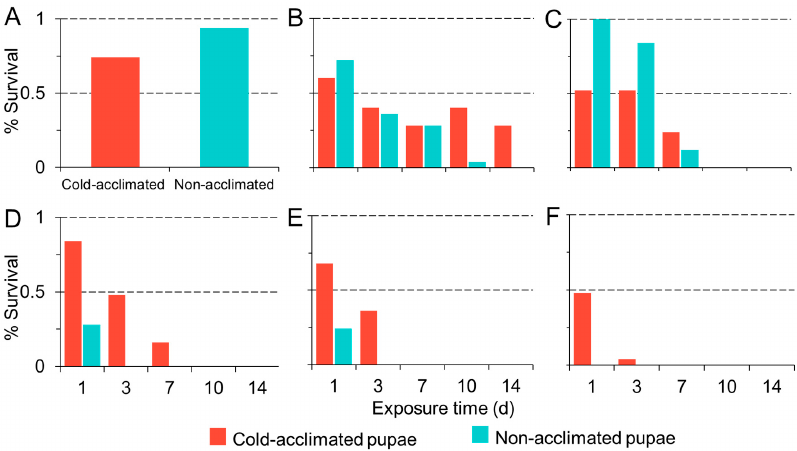
Figure 4. Percent pupal survival (y-axis) of cold-acclimated (blue bars) and non-acclimated (red bars) D. suzukii held at 25 ( A ), 4.4 ( B ), 1.87 ( C ), − 1.11 ( D ), − 3.87 ( E ), and − 6.67 °C ( F ) for up to two weeks (x-axis).